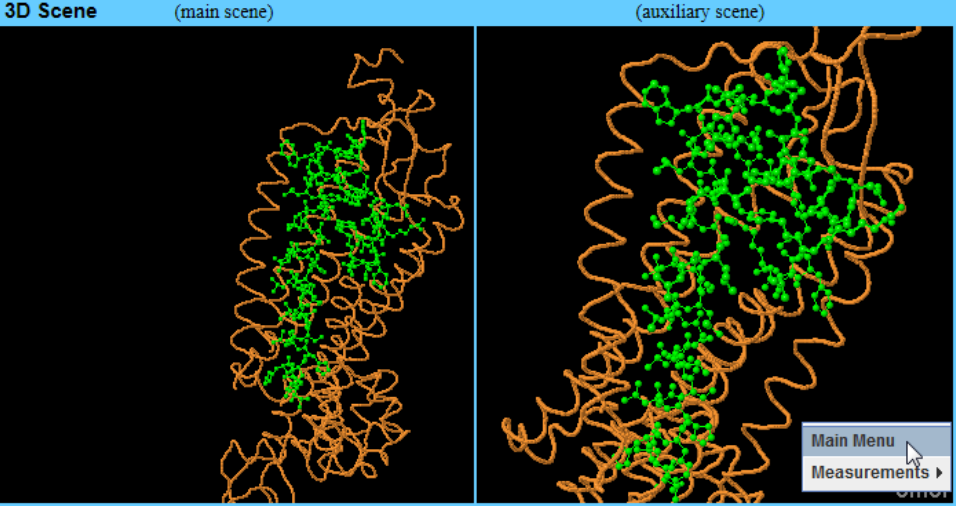
Fig. 4. A demonstration of the two 3D scenes in